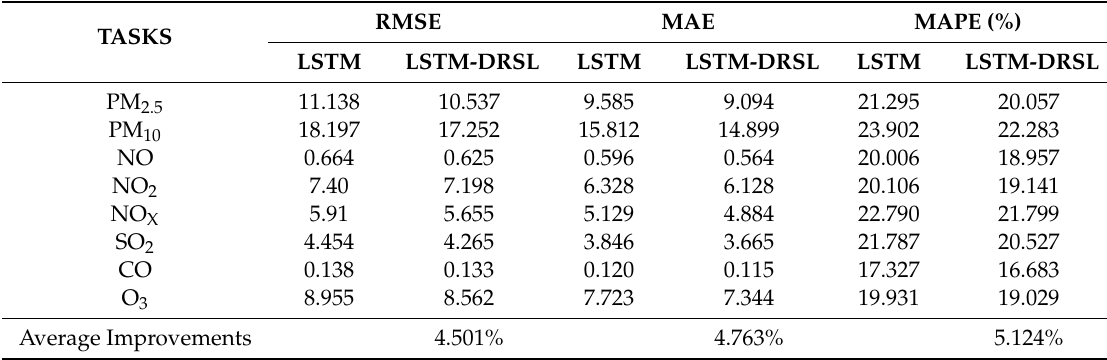
Table 4. Performances using LSTM combined with random subspace